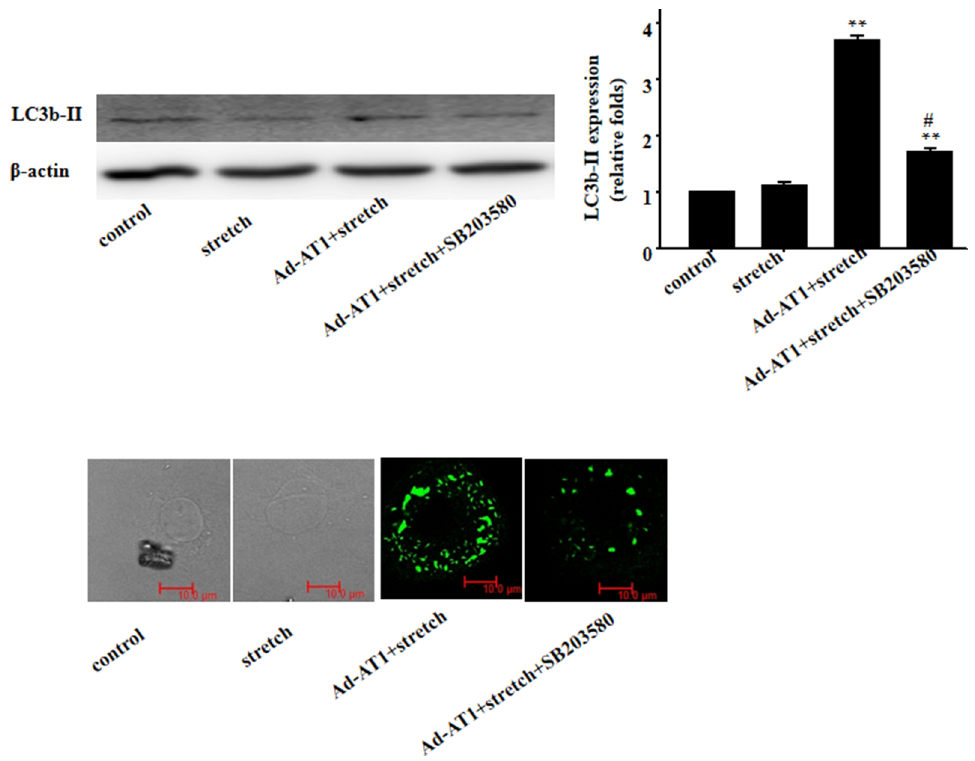
Figure 3. Mechanical stress induced autophagy through AT 1 and p38MAP kinase independently of Ang II. Western blot analyses and immunofluorescent staining for LC3b-II using specific antibody (green); b -actin in whole cell lysate was used as loading control. Representative photograms from 3 independent experiments are shown.